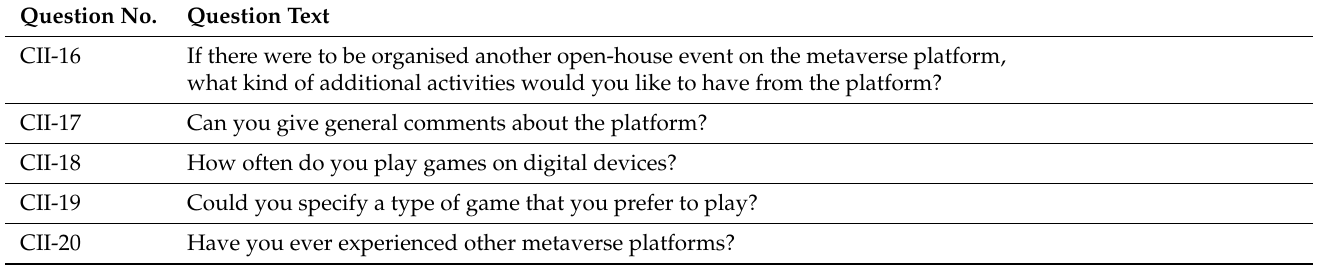
Table 5. A list of five qualitative CII questions. This set of open-ended questions was used to gather additional information about the users’ experiences with the platform, general gaming preferences, and other metaverses.